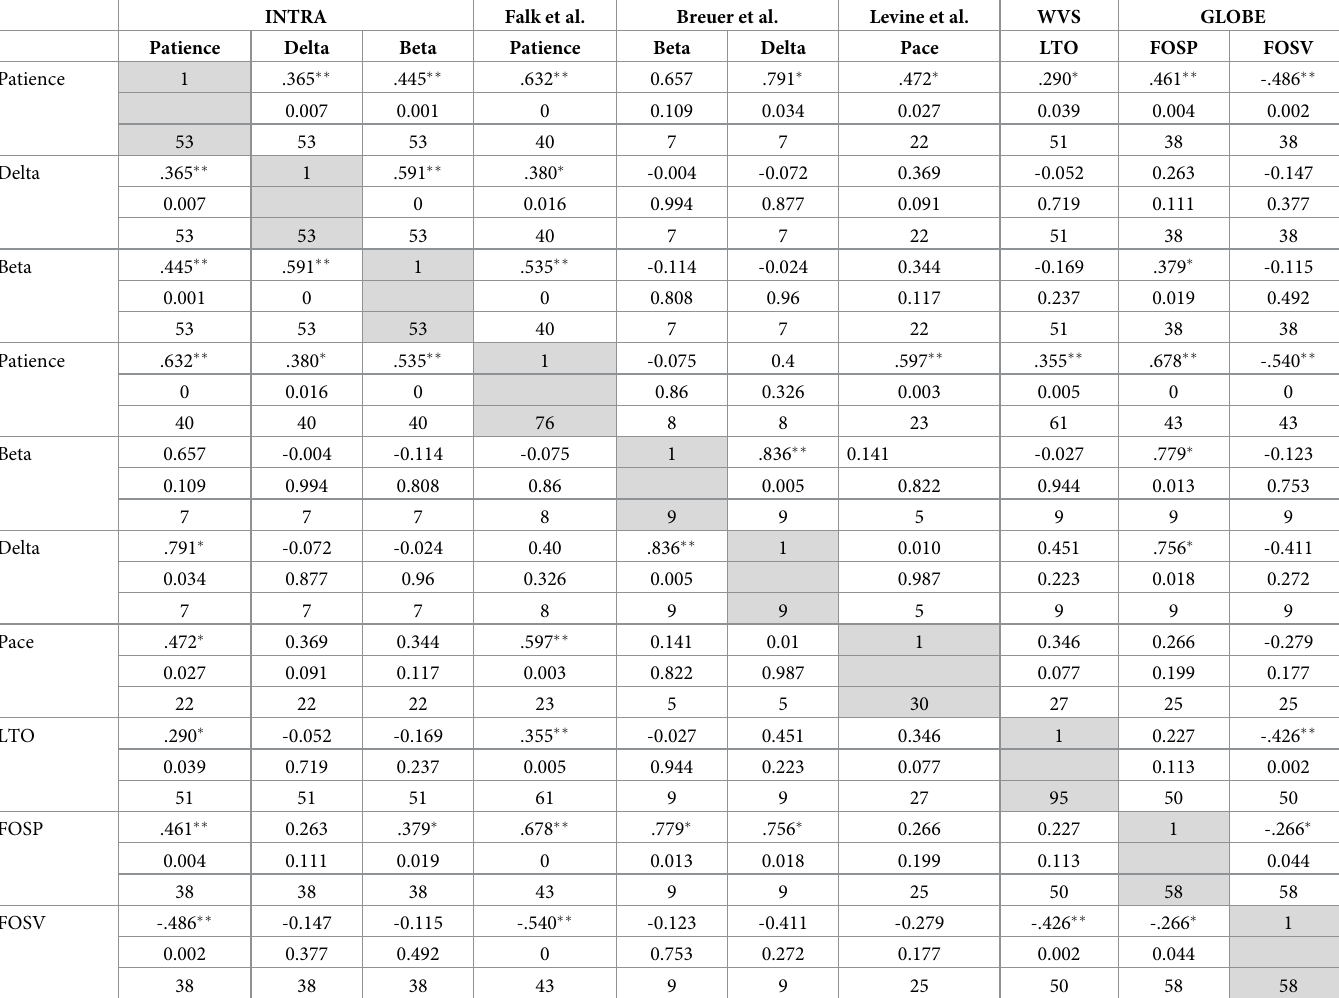
Table 2. Correlations of the ten time-preference